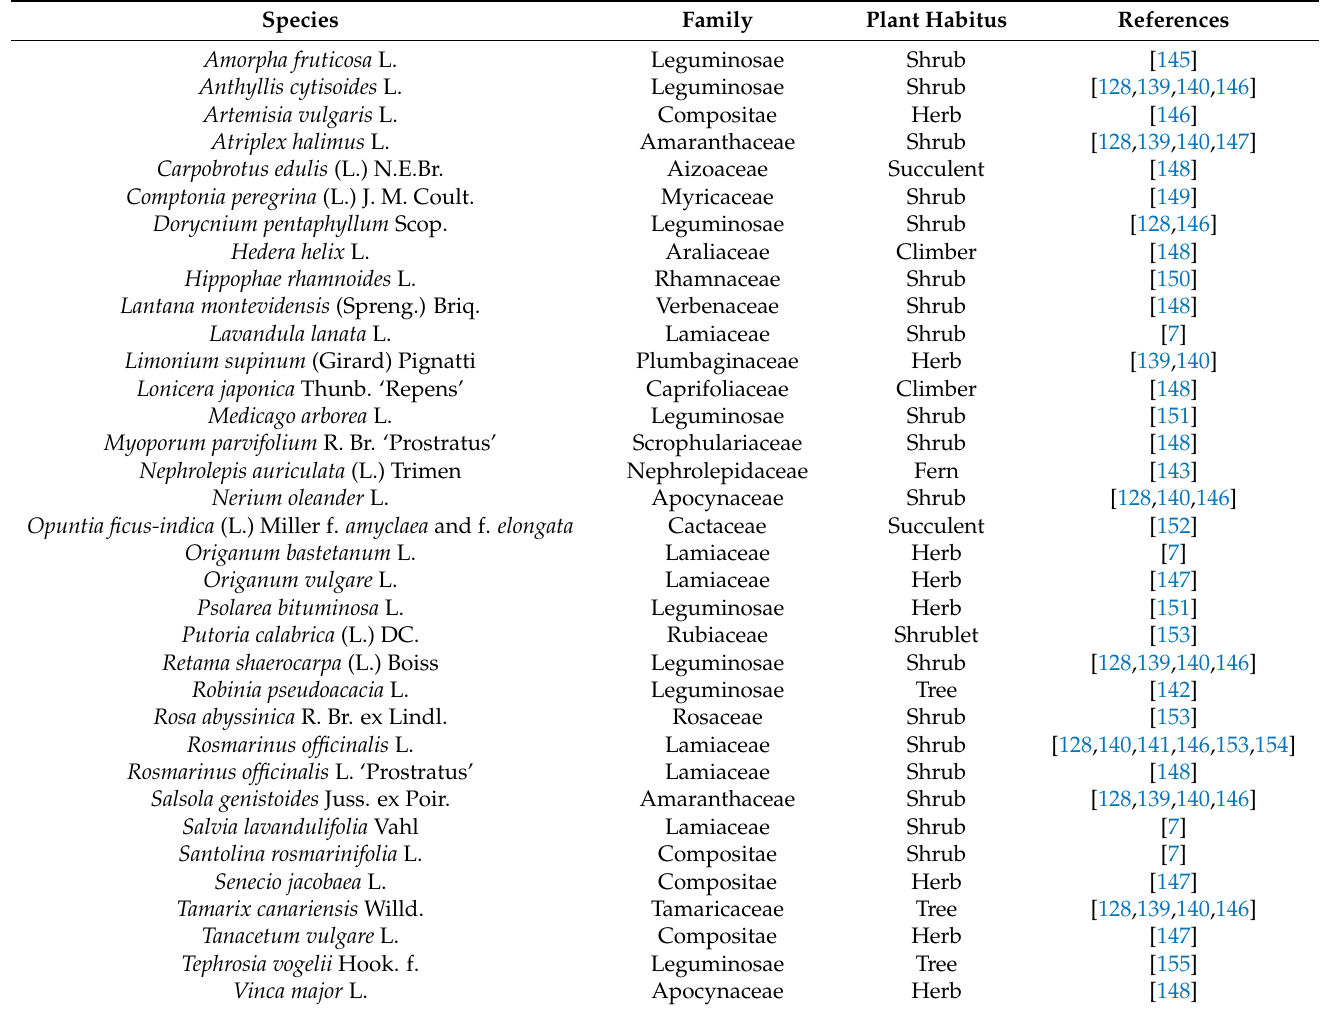
Table 1. Species with ornamental value 1 suitable for erosion